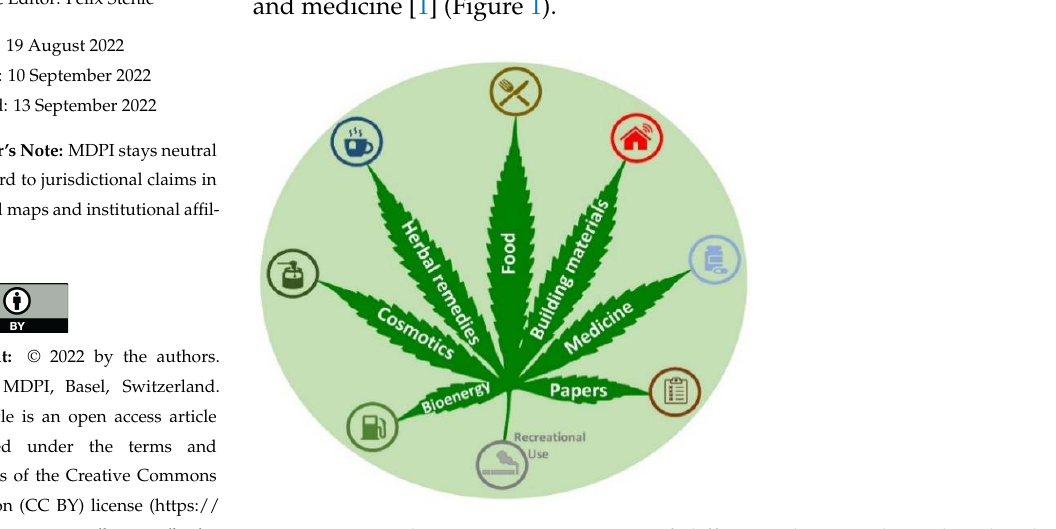
Figure 1. A schematic representation of different pharmacological and industrial applications of cannabis.